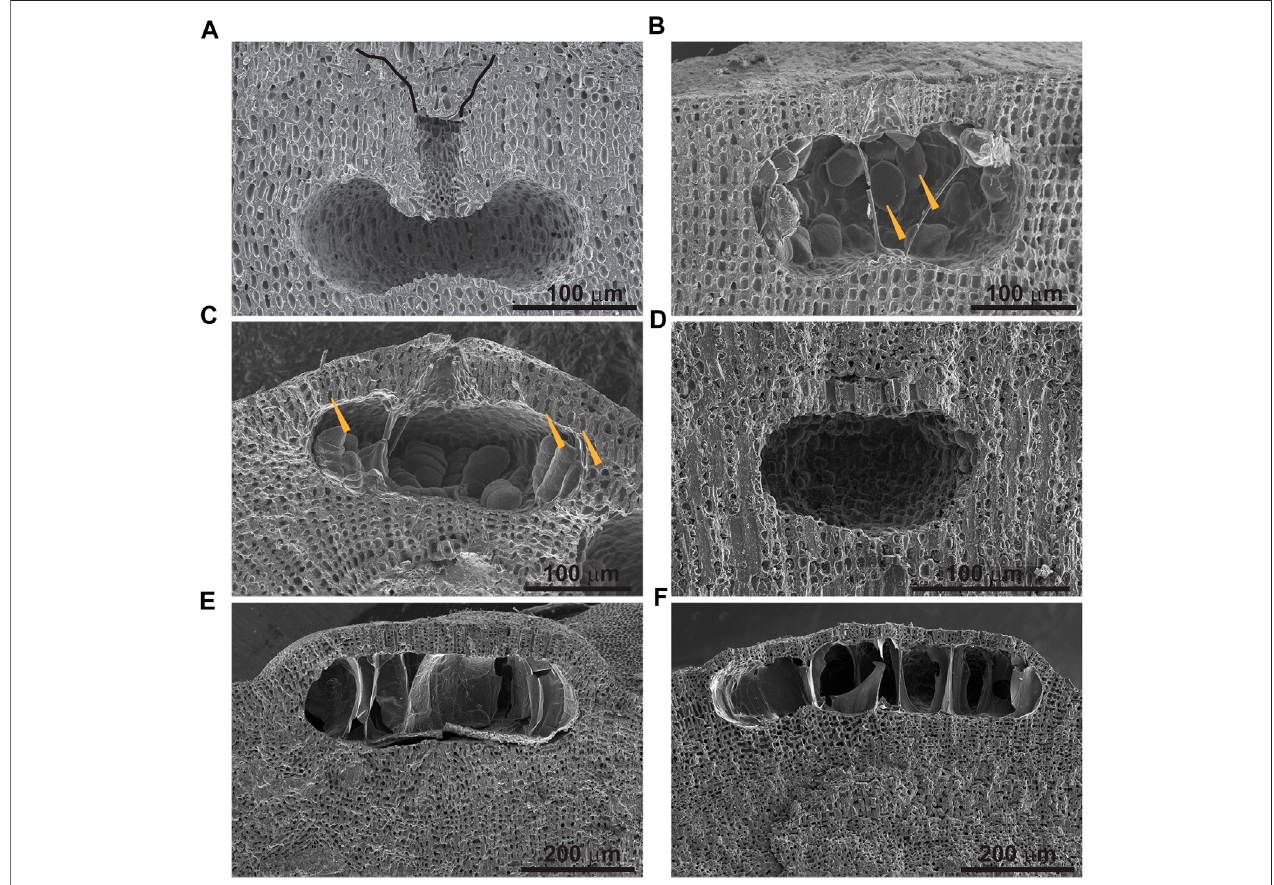
FIGURE7| SEMimagesofselectedexamplesofidenti fi edmorphospecies: (A) Sporangialconceptacleof Lithophyllumhibernicum .Blacklinesmarkthecontourof funnel-like depression on top of conceptacle pore fi lled by overgrowing fi laments; (B) Bisporangial conceptacle of Lithophyllum orbiculatum . Arrowheads point to bispores; (C) Tetrasporangialconceptacleof Lithophyllumnitorum .Arrowheadspointtoelongatedcellsatthebaseofconceptacleroof; (D) Tetrasporangialconceptacle of Phymatolithon calcareum ; (E) Tetrasporangial conceptacle of Lithothamnion corallioides ; (F) Tetrasporangial conceptacle of Lithothamnion valens .